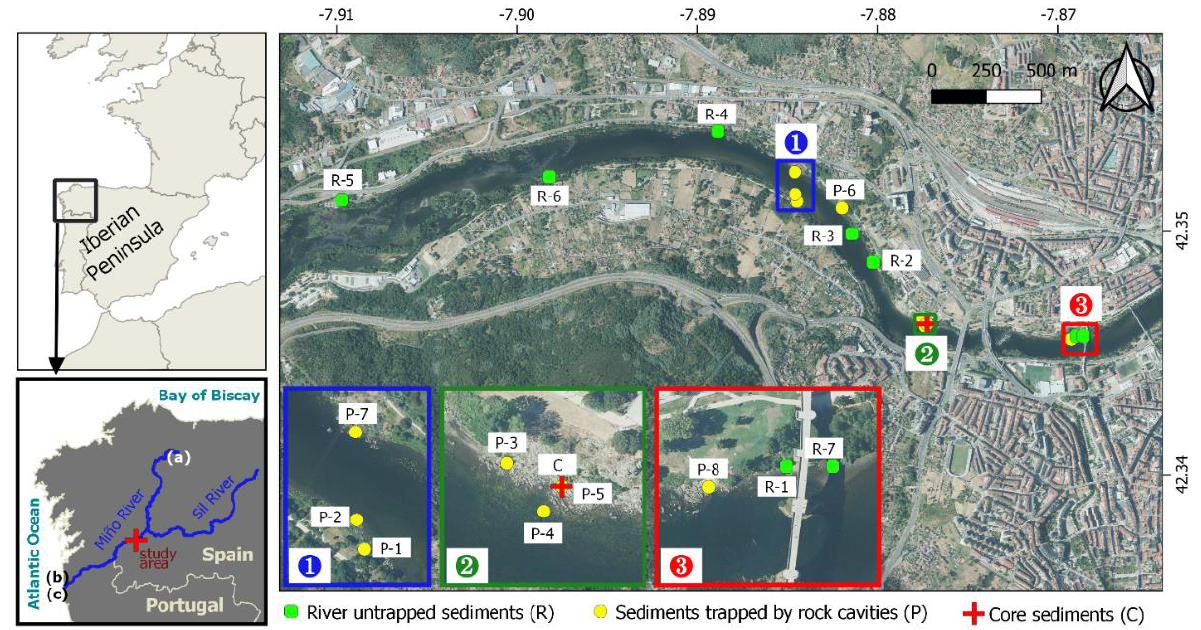
Figure 1. Location map of the study area and samples position, (a) indicates the springs of the Miño River in Serra de Meira, (b) and (c) are the localities of A Guarda (Spain) and Caminha (Portugal), respectively. Basemap aerial orthophoto from the Spanish-PNOA (© IGN).